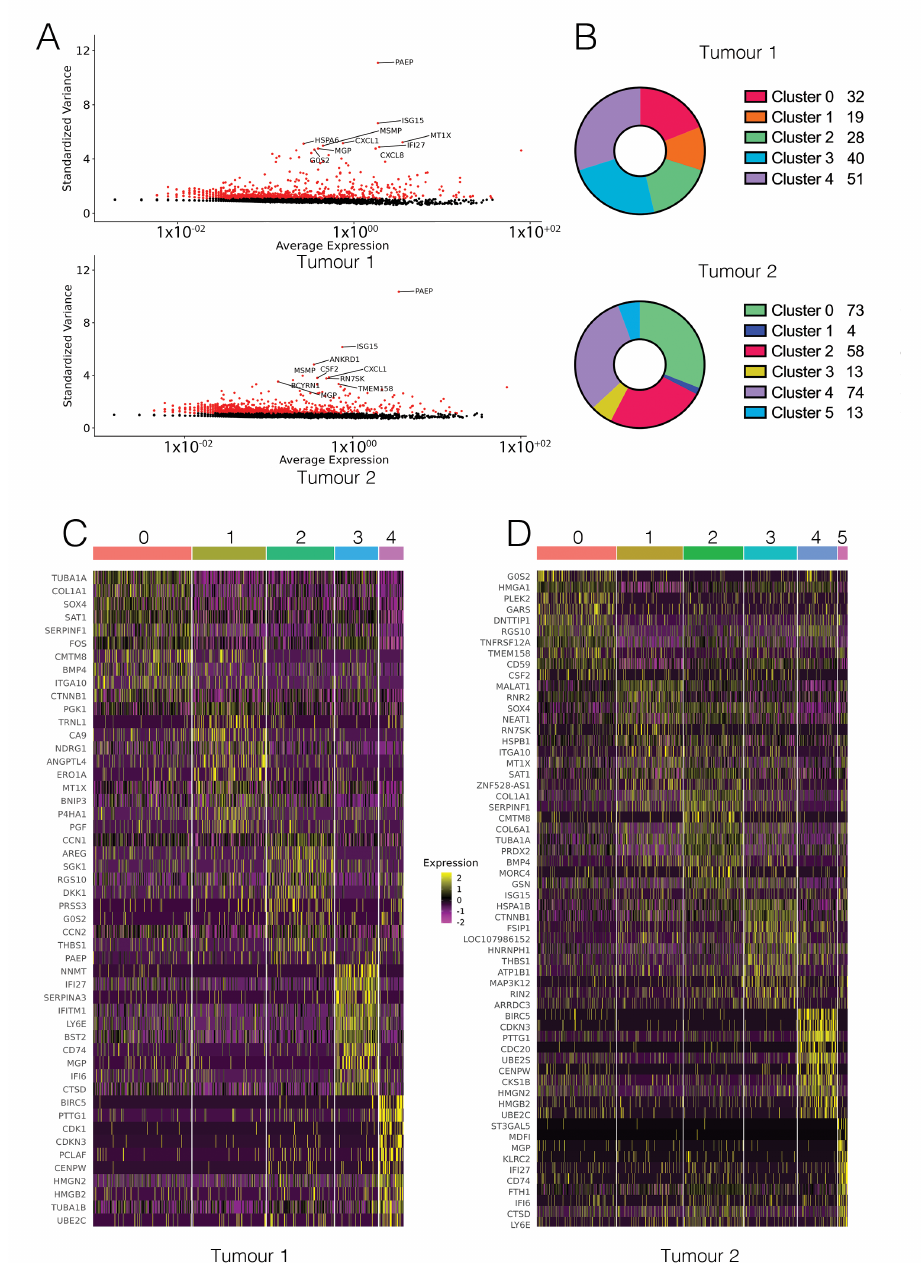
Figure 2. Subpopulations in cell-line derived xenografts form clusters. ( A ) The top 2000 most variable genes for each sample were highly comparable, and included genes known to be associated with cancer phenotypes. ( B ) Number of significantly upregulated genes for each cluster. Clusters are coloured by similarity between T1 and T2. ( C ) Heatmap showing the top 10 genes for each T1 cluster, coloured by expression (Log2FC). ( D ) Heatmap showing the top 10 genes for each T2 cluster, coloured by expression